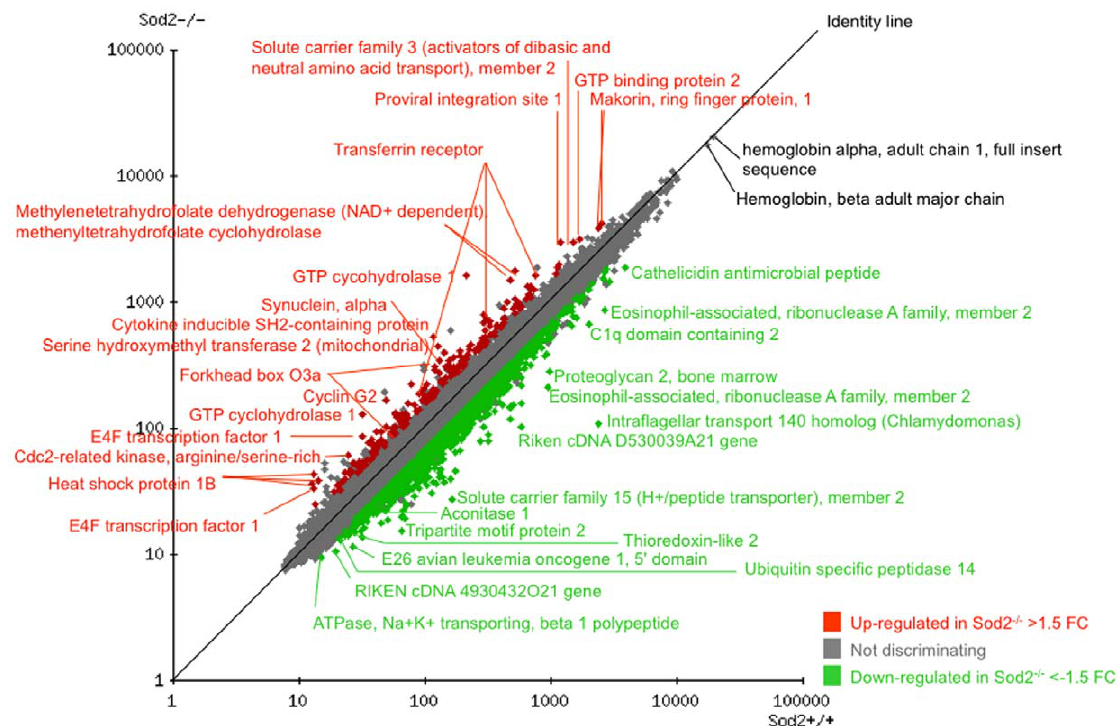
Figure 2. Overview of gene expression comparison of Sod2 -/- vs. Sod2 + / + erythroblasts. Scatterplot highlights genes expressed . 1.5 fold higher (red) or lower (green) in Sod2 -/- compared to Sod2 + / + cells. X and Y axes plot relative expression values derived from microarray intensities. Spots corresponding to selected highly differentially expressed genes are identified. Among the most highly expressed genes are the hemoglobin alpha and beta chains, that show no difference between Sod2 -/- and Sod2 + / + samples. In Sod2 -/- erythroblasts, there are more than twice as many transcripts with reduced vs. increased expression. A full listing of differential transcripts (with corrected p , 0.05 and fold-change . 6 1.5) is in table S1.